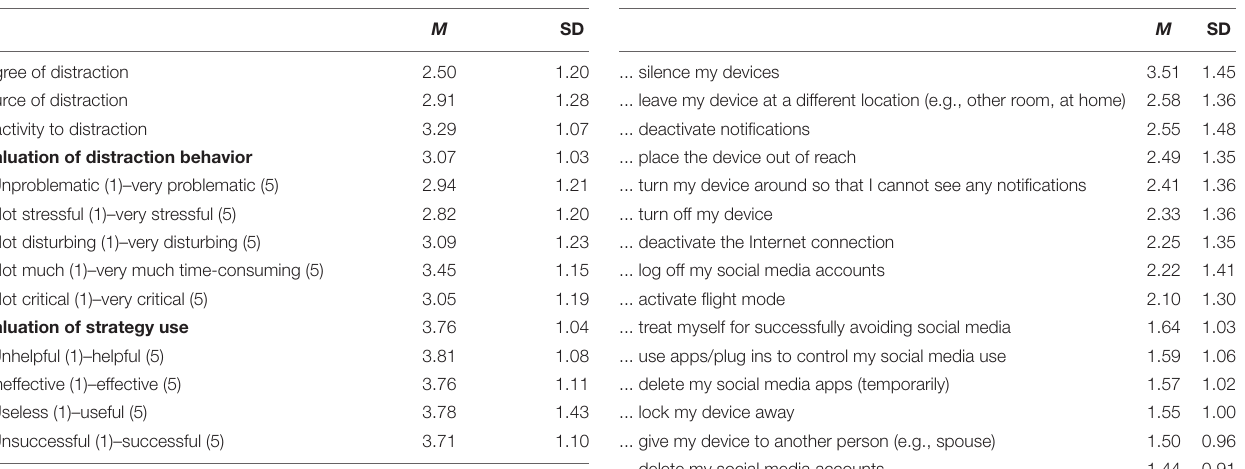
TABLE 2 | Descriptive measures on distraction by social media. TABLE 4 | Strategies used to reduce distractions by social